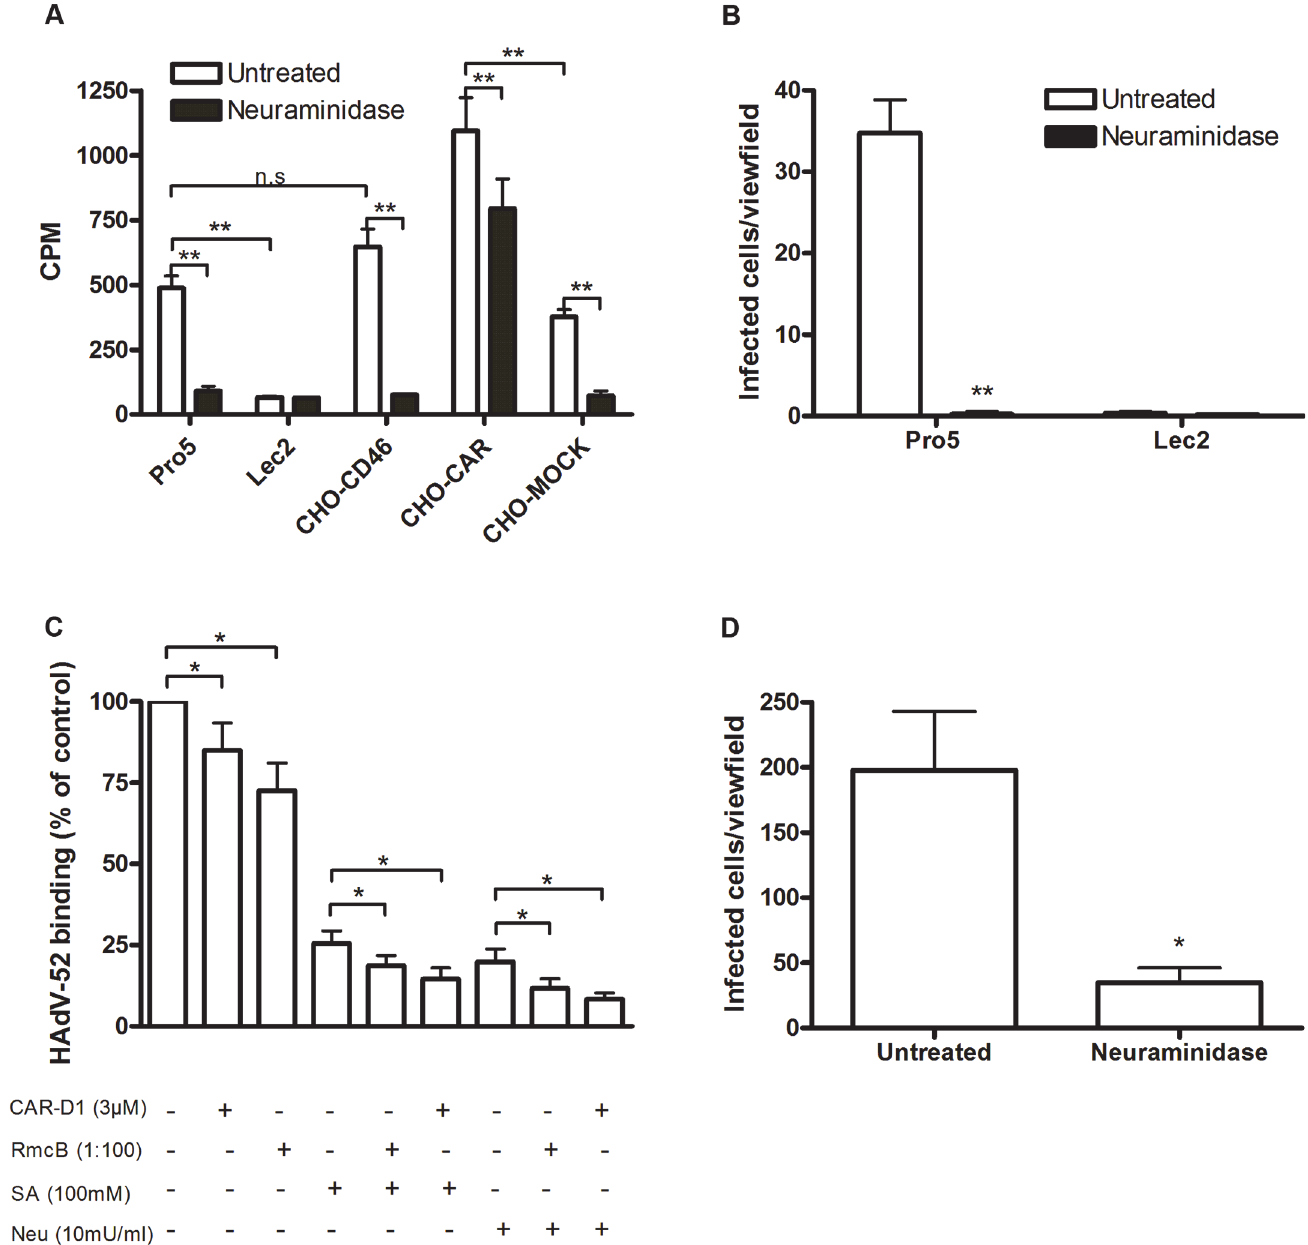
Fig 1. HAdV-52 uses sialic acid and CAR for binding to and infection of cells. (A) 35 S-labeled HAdV-52 virion binding to CHO cells expressing or lacking known HAdV receptors. Pro-5 is a sialic acid-positive, reference cell line and parental cell line to sialic acid-negative Lec2 cells. CHO-CD46 and CHO-CAR cells express human CD46 and CAR, respectively. CHO-MOCK is mock transfected with respect to CHO-CAR. Black bars show HAdV-52 binding to cells after pretreatment with V . cholerae neuraminidase. Binding was quantified by liquid scintillation counting and shown as counts per minute (CPM). (B) HAdV- 52 infection of Pro-5 and Lec2 pretreated with (black bars) or without (white bars) V . cholerae neuraminidase. The number of infected cells was quantified by immunofluorescence. (C) 35 S-labeled HAdV-52 virion binding to A549 cells. Virions were preincubated with or without soluble CAR-D1 or sialic acid monosaccharides, and cells were preincubated with or without mouse anti-CAR mab (clone RmcB) or V . cholerae neuraminidase as indicated, prior to binding. (D) HAdV-52 infection of A549 cells pretreated with or without V . cholerae neuraminidase. All experiments were performed three times with duplicate samples in each experiment. Error bars represent mean ± SD. n.s = not significant, * P of < 0.05 and ** P of < 0.01.